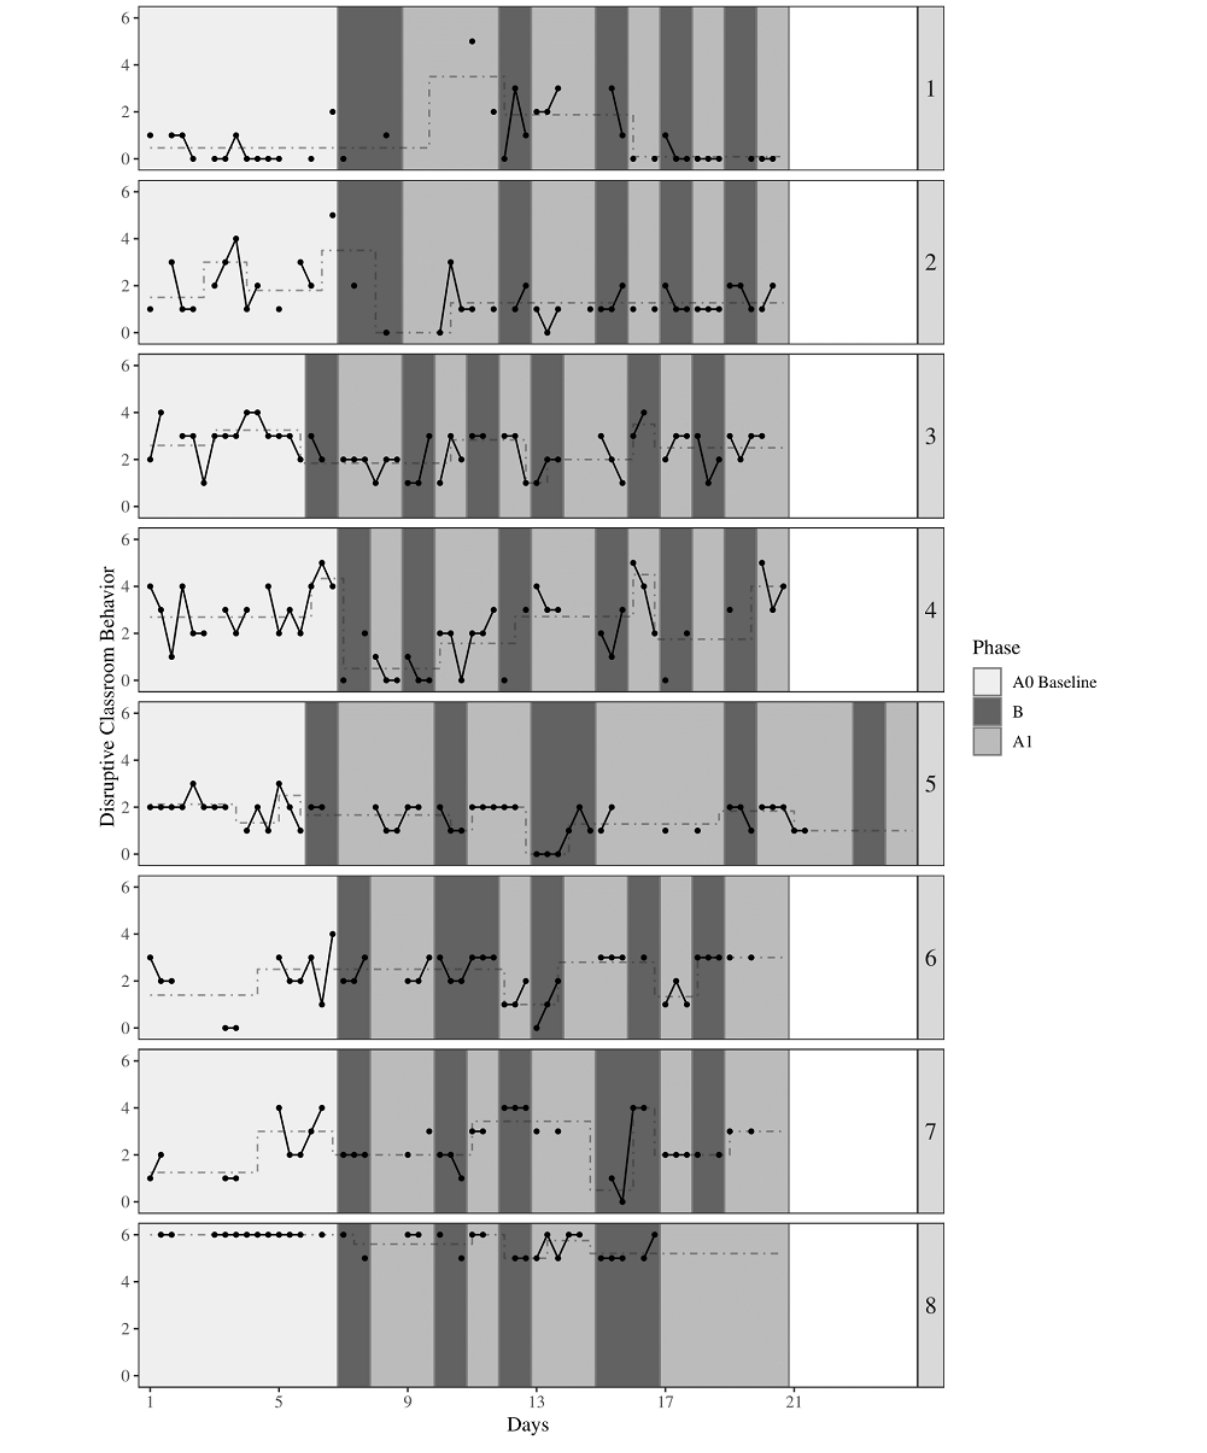
Figure 3. The effect of DEEP on disruptive classroom behavior for 8 adolescents. Every 3 data points represent 1 day (measured around 10:20 AM, 12:25 PM, and 2:30 PM). The dashed and stepped lines represent the relatively stable disruptive classroom behavior levels that were identified using recursive